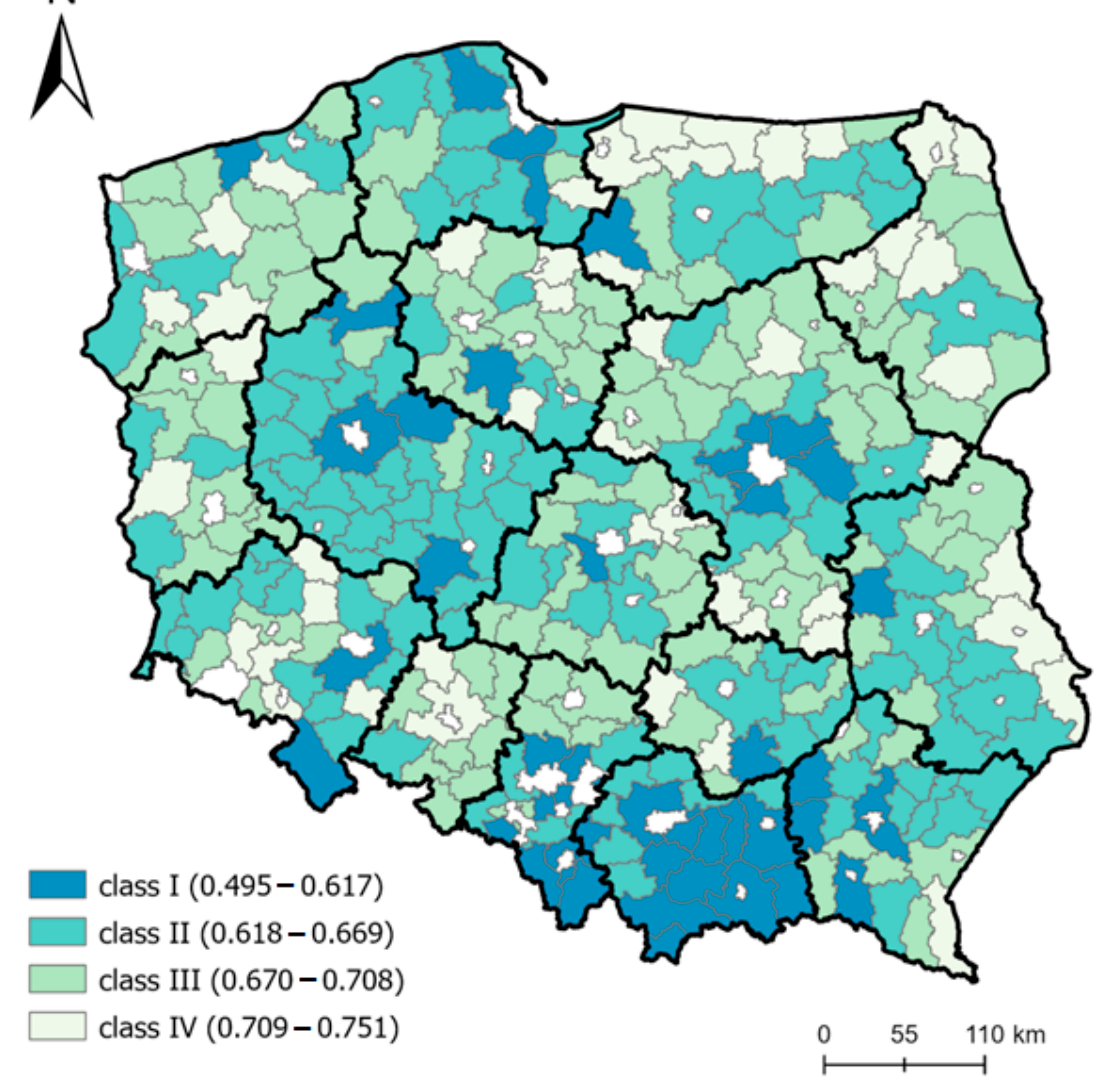
Figure 3. Model for classifying areas with different levels of vulnerability to epidemic threats. Source: own elaboration.